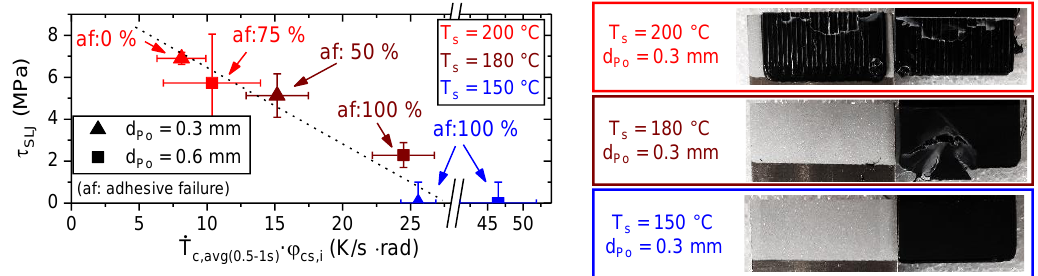
. T c , avg ( 0.5 − 1 s ) , and the